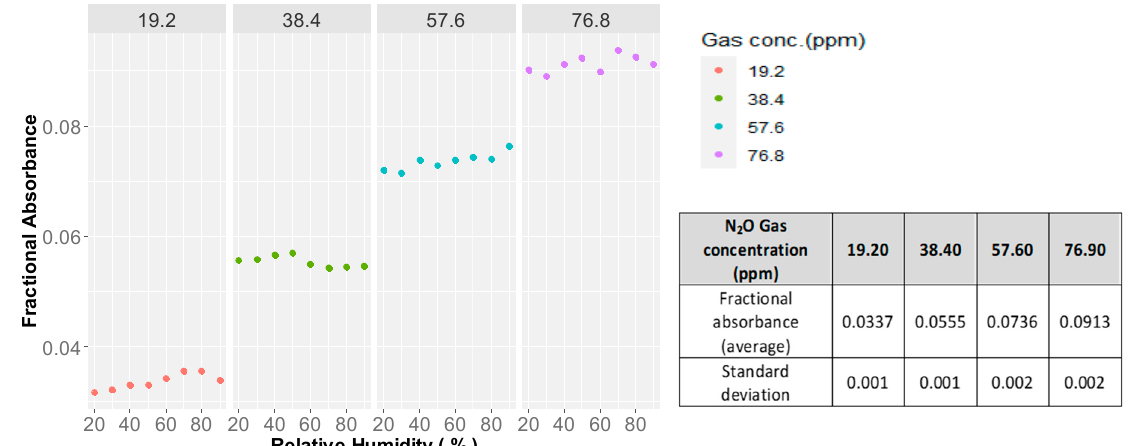
Figure 8. Fractional IR absorbance by N 2 O gas at different relative humidity levels.